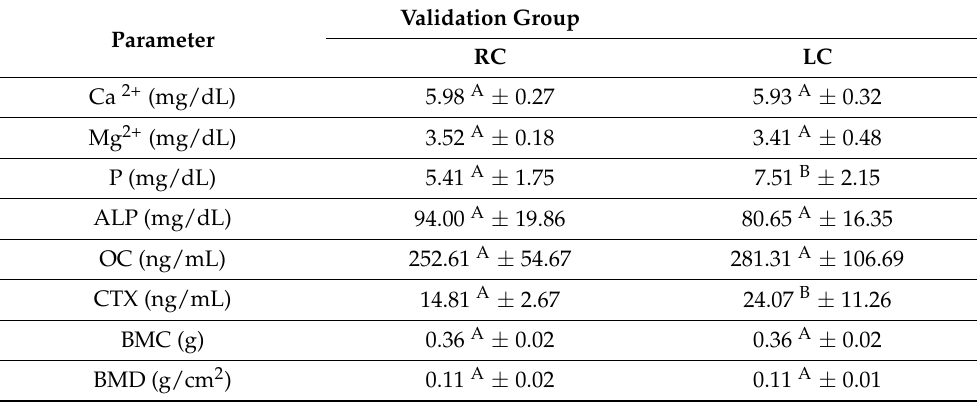
Table 2. The level of selected parameters of mineral metabolism in growing rats after 12 weeks of feeding—validation model.